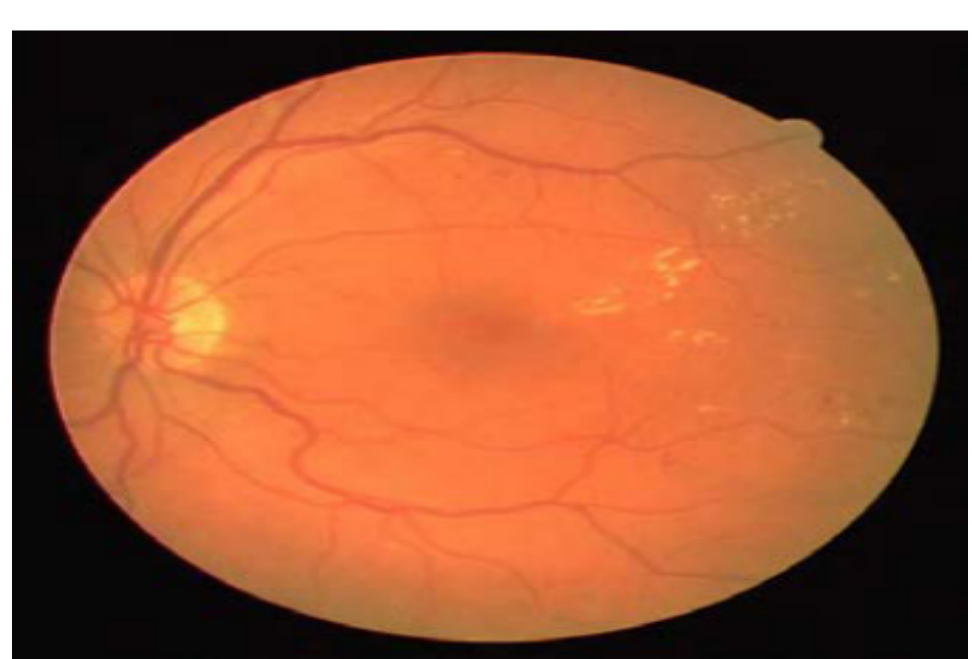
Figure 7. An example of severe retinal blood vessel tortuosity in a patient with severe non-proliferative (NPDR) disease [19].